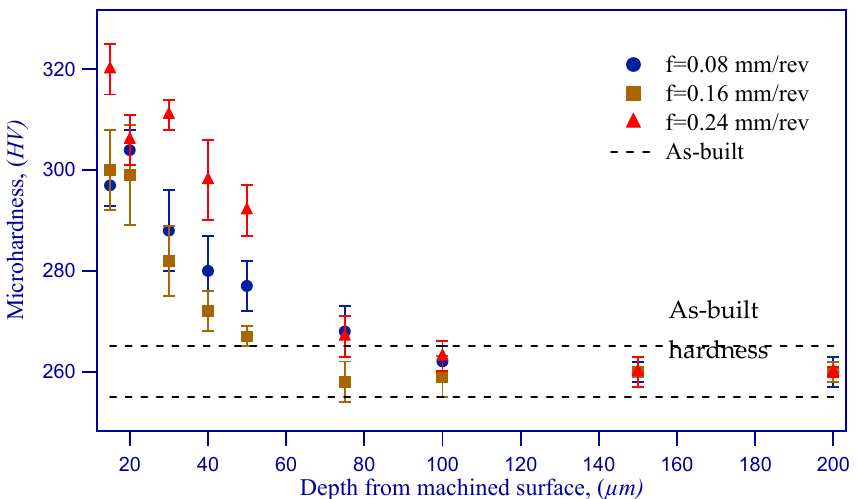
Figure 14. Microhardness of finish- machined and as-built SLMed 316L stainless steel as a function of feed rate ( V c = 150 m/min).